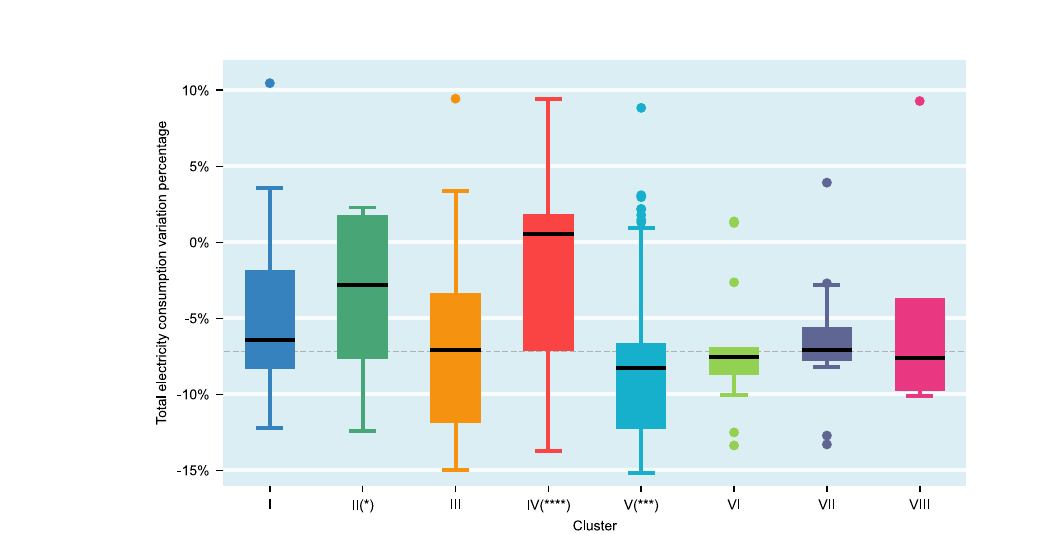
MSAs. Two-sided Wilcoxon rank sum tests of each Cluster versus all the MSAs are performed, and n 2 =380 which is the case for all the eight tests. Cluster I: p =0.0709, n 1 =44, W = − 1.8063;ClusterII: *p =0.0116, n 1 =19, W = − 2.5246;ClusterIII: p =0.4784, n VII: p =0.8865 , n 1 =16, W = − 0.1427; Cluster VIII: p =0.8476, n 1 =5, W = −